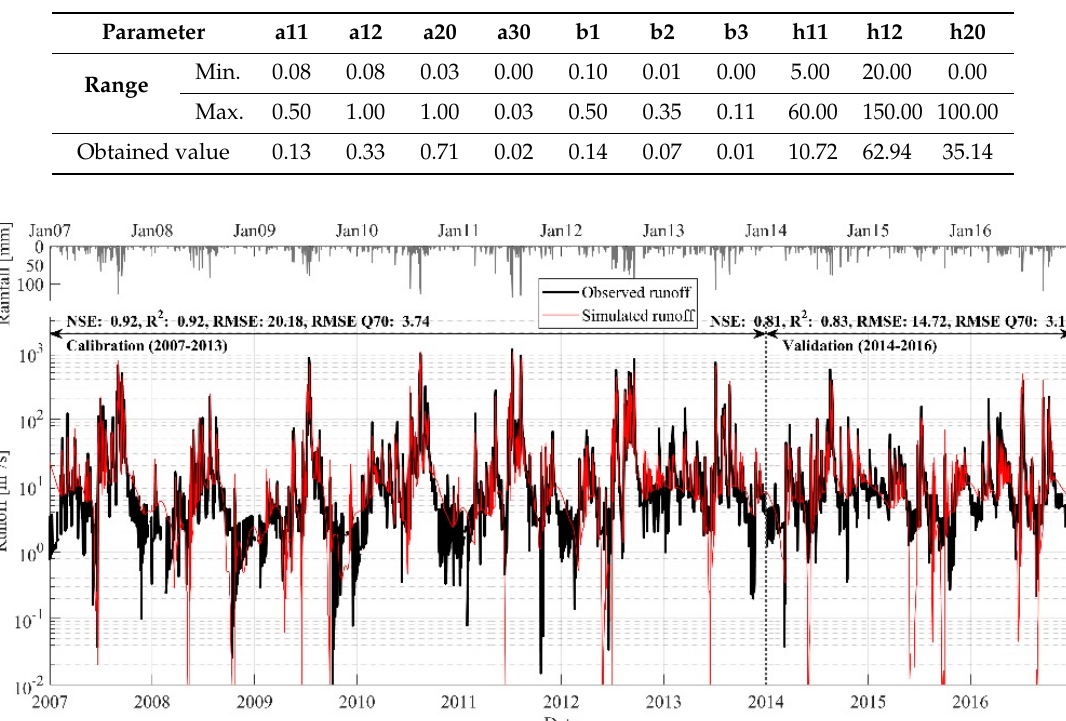
Table 2. Parameter ranges and optimum values estimated through the calibration process. Here, the parameter ranges were set based on previous studies (Kim and Park, 1988; Song et al., 2017).